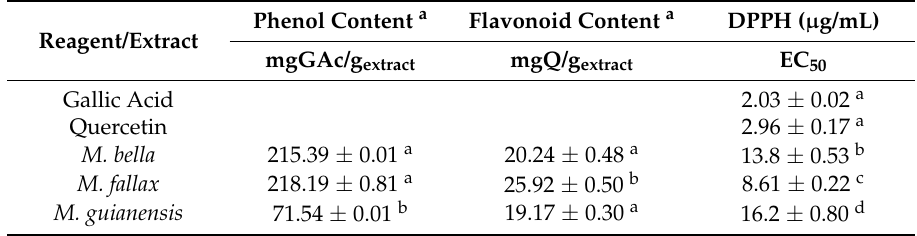
Table 3. Antioxidant results of Myrcia spp. extracts measured by DPPH. Phenol and flavonoid content